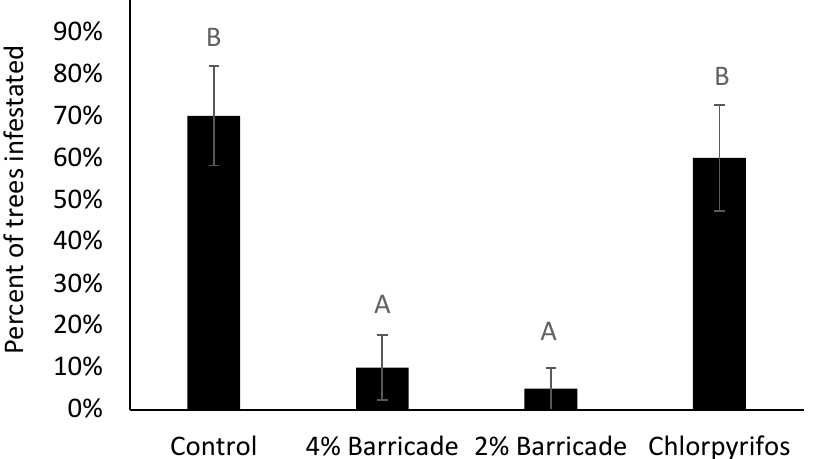
Figure 4. Percentage of peach trees infested with peachtree borers, comparing rates of Barricade ®